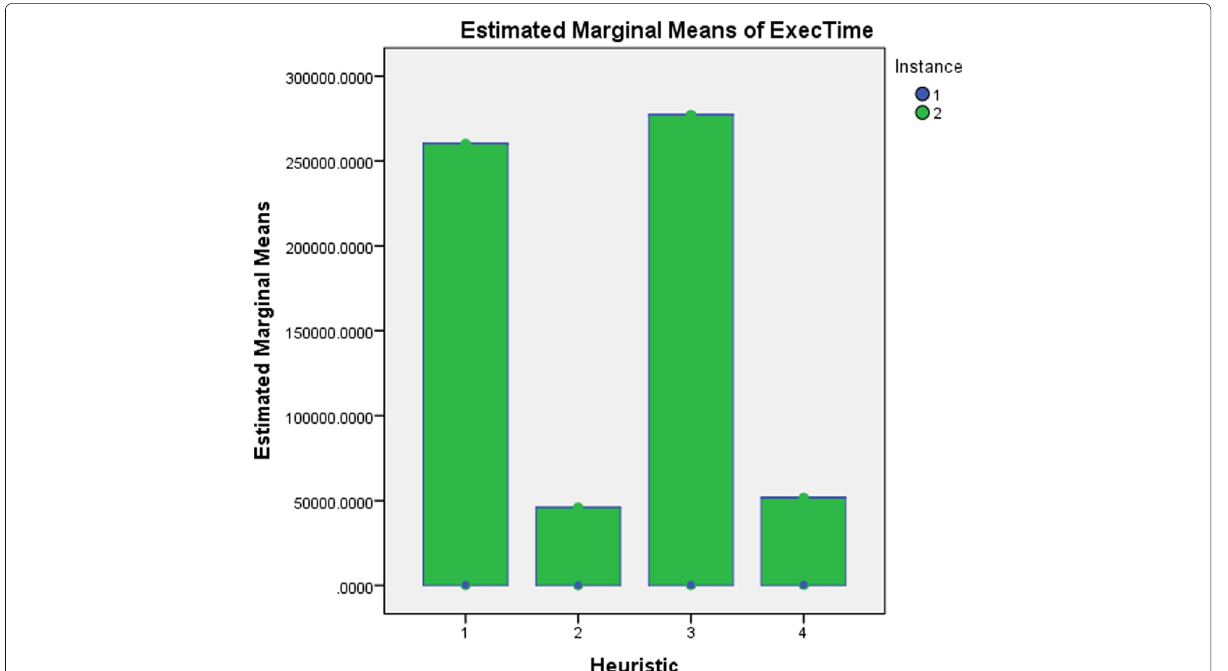
Fig. 15 Computational effort - 1